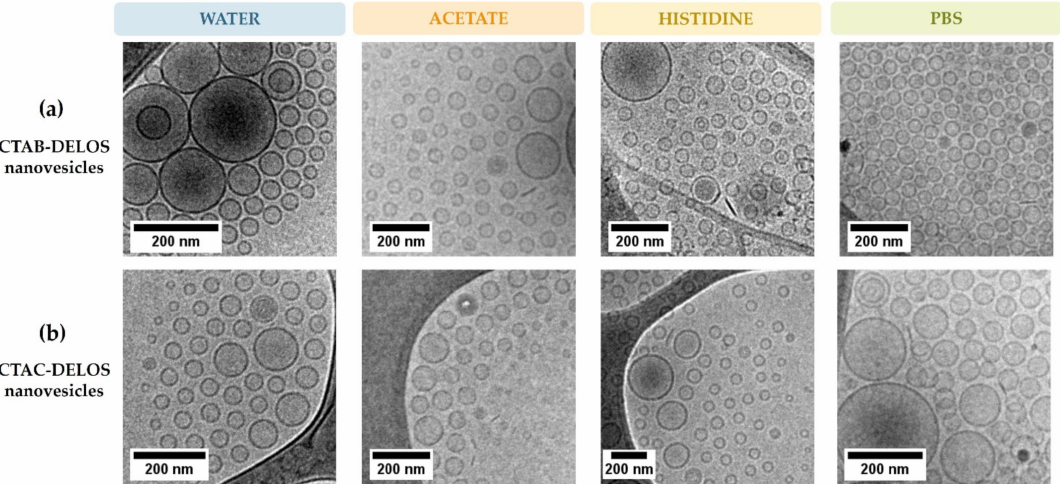
Figure 3. Cryo-TEM images of ( a ) CTAB-DELOS nanovesicles and ( b ) CTAC-DELOS nanovesicles in different dispersant media: water (blue); 5 mM acetate, pH = 5.0 (orange); 5 mM histidine, pH = 7.0 (yellow); and 5 mM PBS, pH = 7.4